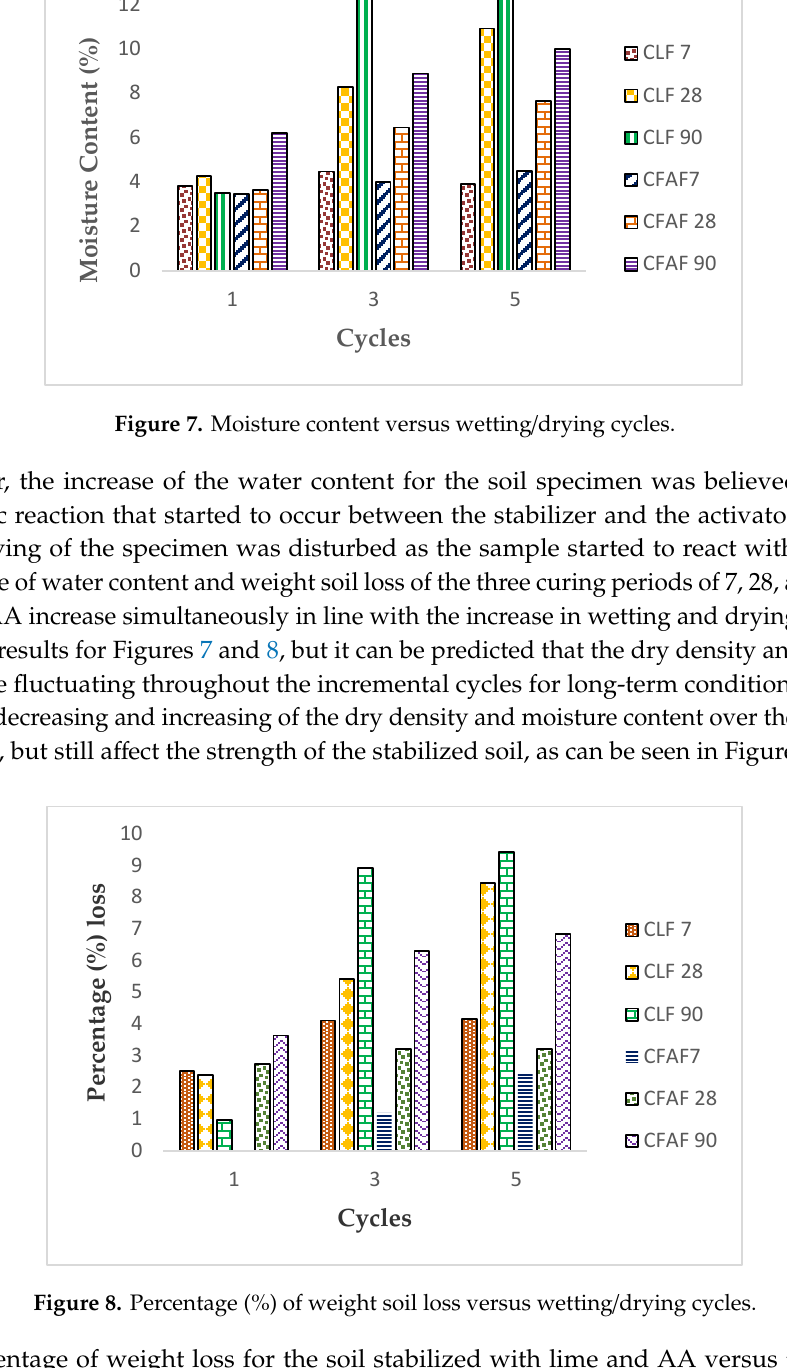
Figure 6. Dry density versus wetting/drying cycles.